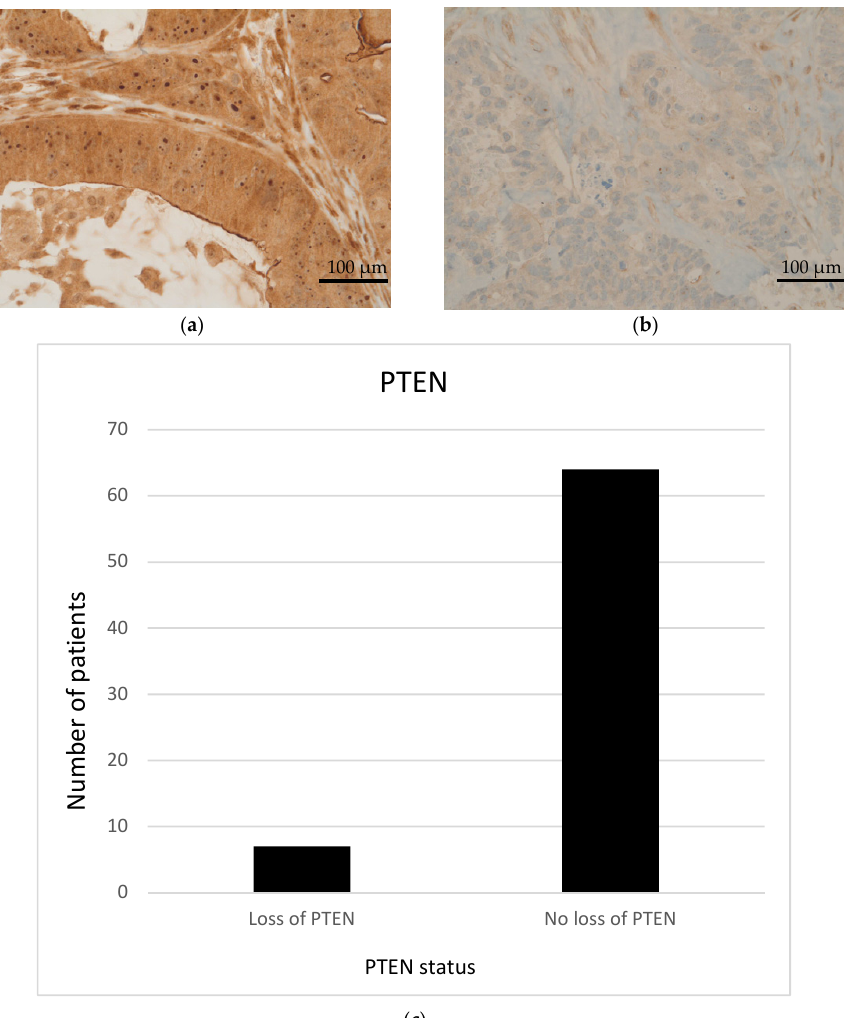
Figure 3. ( a ) Representative image of high expression of PTEN (IHC score = 300). ( b ) Representative image of low expression of PTEN. (Images by kind courtesy of Prof. Dr. Müllauer). ( c ) Loss of PTEN in 9 out of 71 patients with therapy − refractory solid tumors. Scale bar = 100 µm.